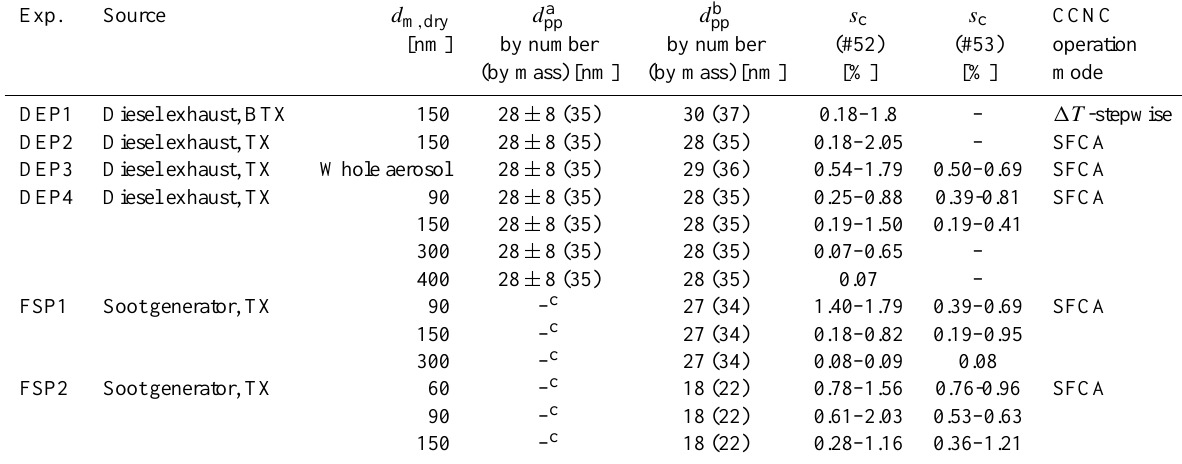
Table 1. Experimental details of the dry particle mobility diameter ( d m , dry ) , the primary particle diameter ( d pp ) , the critical supersaturation measured by the two different CCNC instruments ( s c , #52 and s c , #53), and CCNC operational mode: conventional ( 1T -stepwise) or scanning flow